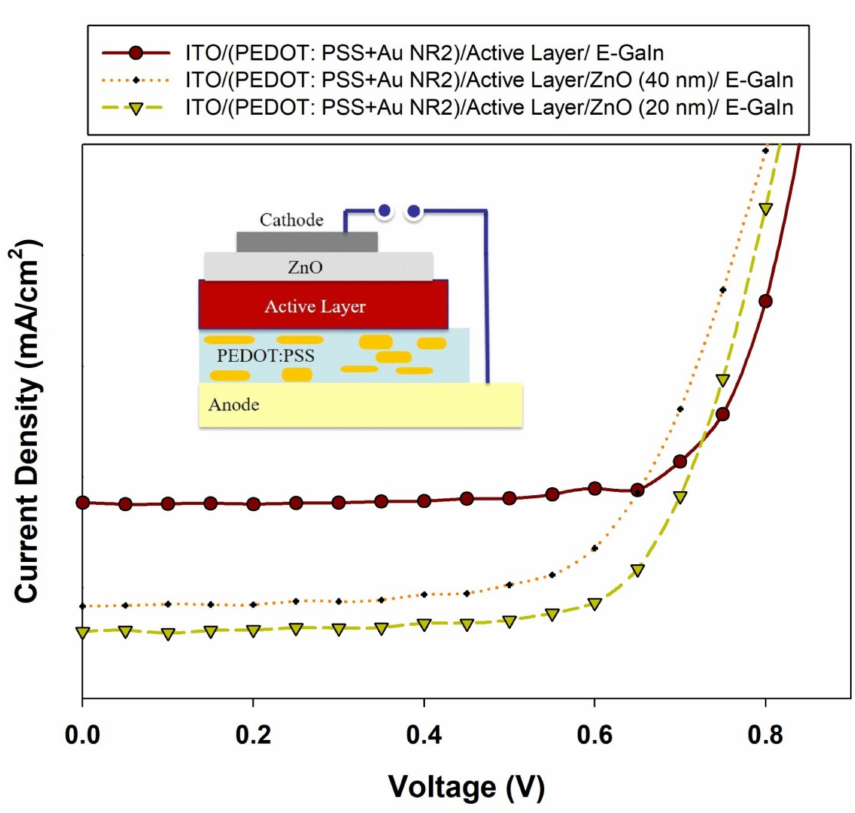
Figure 6. The current density–voltage (J-V) curves of the device without and with ZnO layer; (Inset) Complete device with structure of ITO/(PEDOT:PSS + Au NR2)/(PTB7 + SnS 2